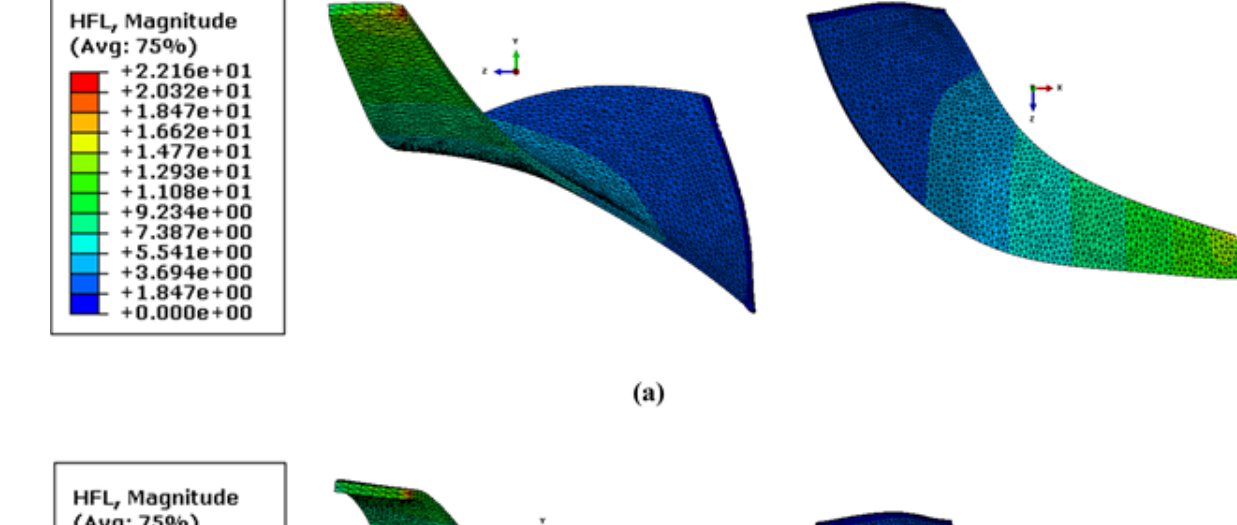
Figure 10: Heat flux fields for: (a) β 2 = 75 ∘ ; (b) β 2 = 90 ∘ ; (c) β 2 = 120 ∘